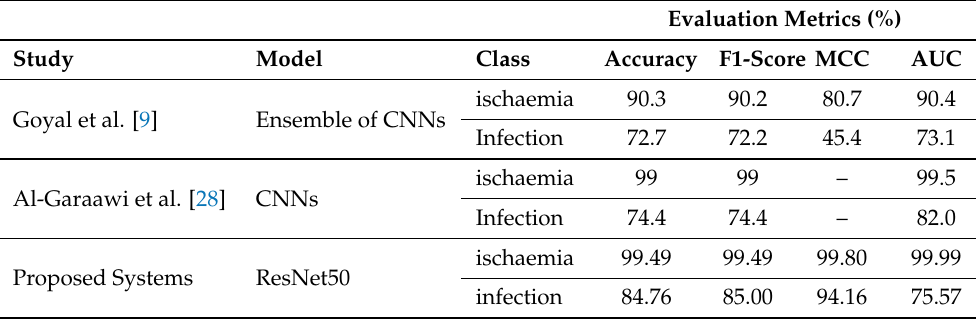
Table 2. Comparative analysis of the proposed system with other systems for DFU